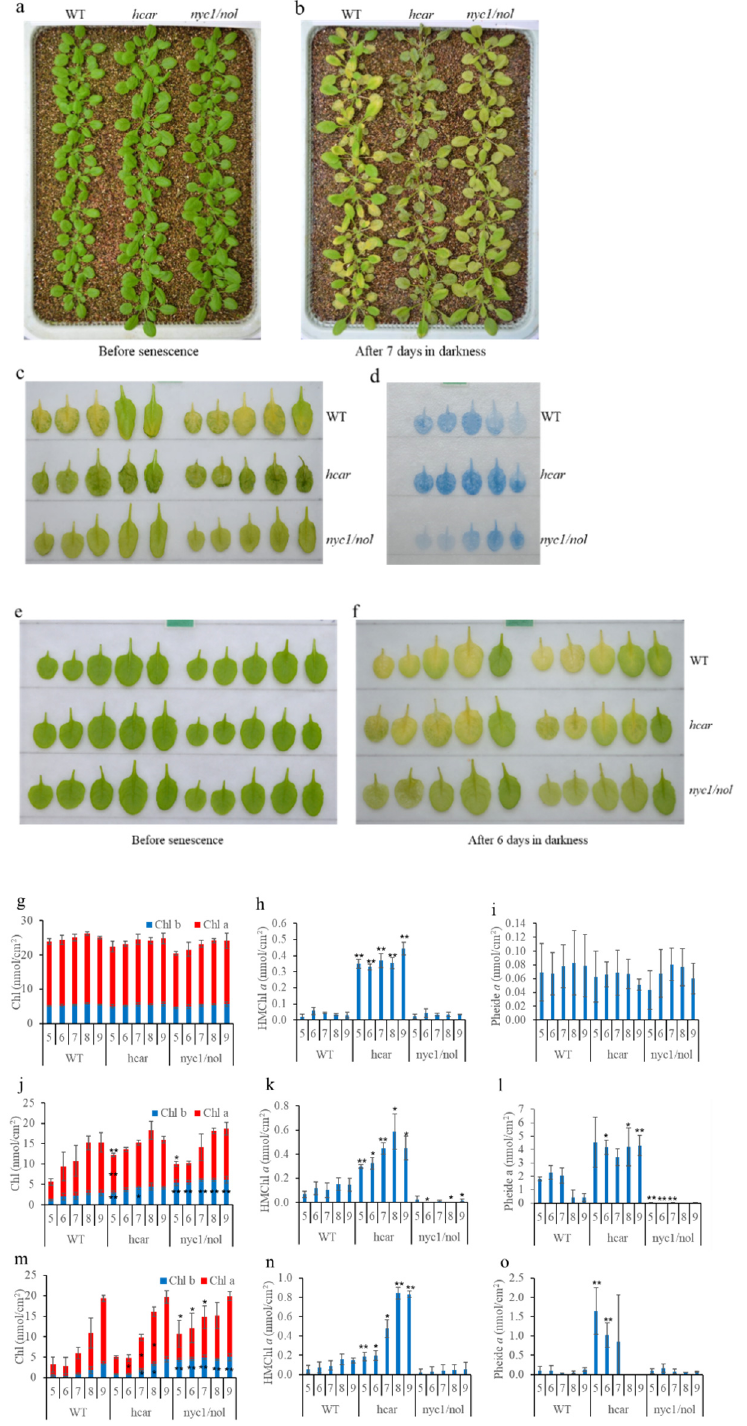
Figure 1. Phenotypic and Chl metabolic characterization of WT, hcar and nyc1/nol plants during dark-induced senescence. ( a , b ) Four-week-old WT, hcar , and nyc1/nol plants grown in soil before and after incubation in darkness for seven days. ( c ) No. 5–9 leaves (leaf numbers are counted from the bottom (oldest) to the top (youngest) of the plants) detached from dark incubated plants. ( d ) Detached No. 5–9 leaves from dark-induced plants stained with trypan blue. ( e , f ) Detached leaves from 4-week-old WT, hcar , and nyc1/nol plants before and after incubation in darkness for six days. ( g–i ), ( j–l ) and ( m–o ): Chl, HMChl a , and Pheide a content in No. 5–9 leaves ( g–i ) before, ( j–l ) after intact plant, and ( m – o ) after detached leaf incubation in darkness, respectively. Values